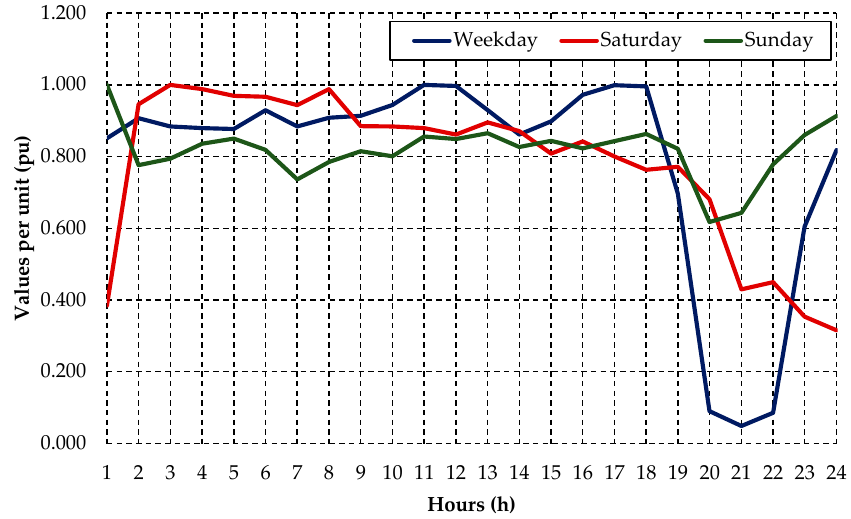
Figure 6. Typology of the daily load profile for public lighting. Source: The authors.